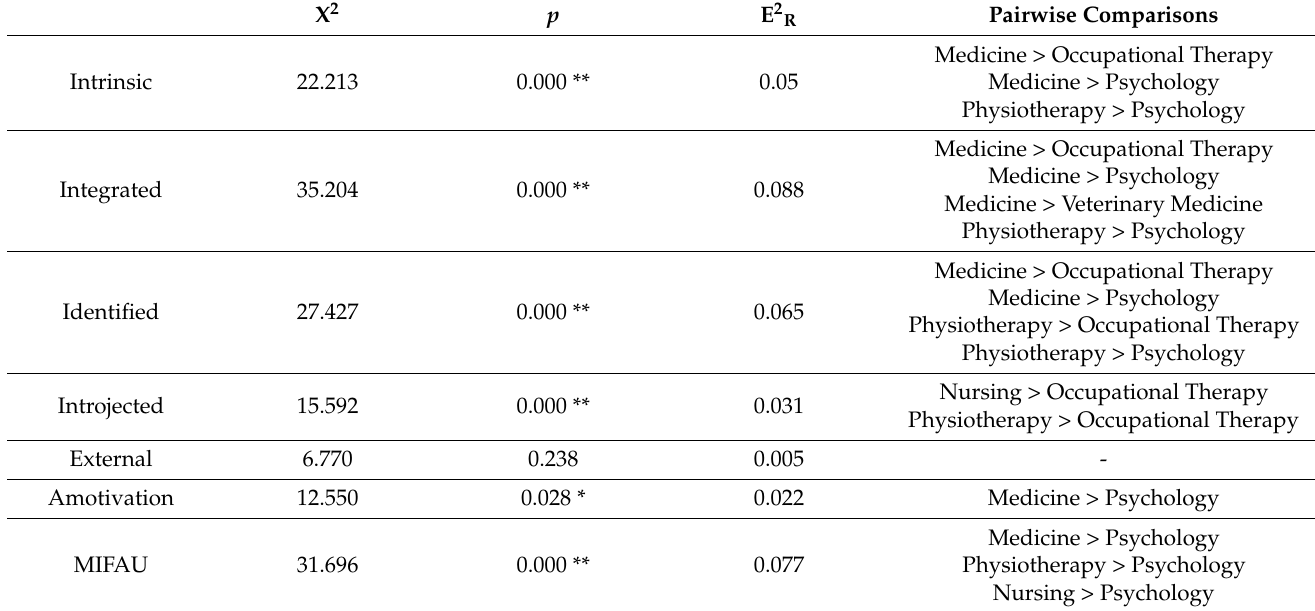
Table 4. Regulation of motivation and intention to engage in PA according to academic degree.